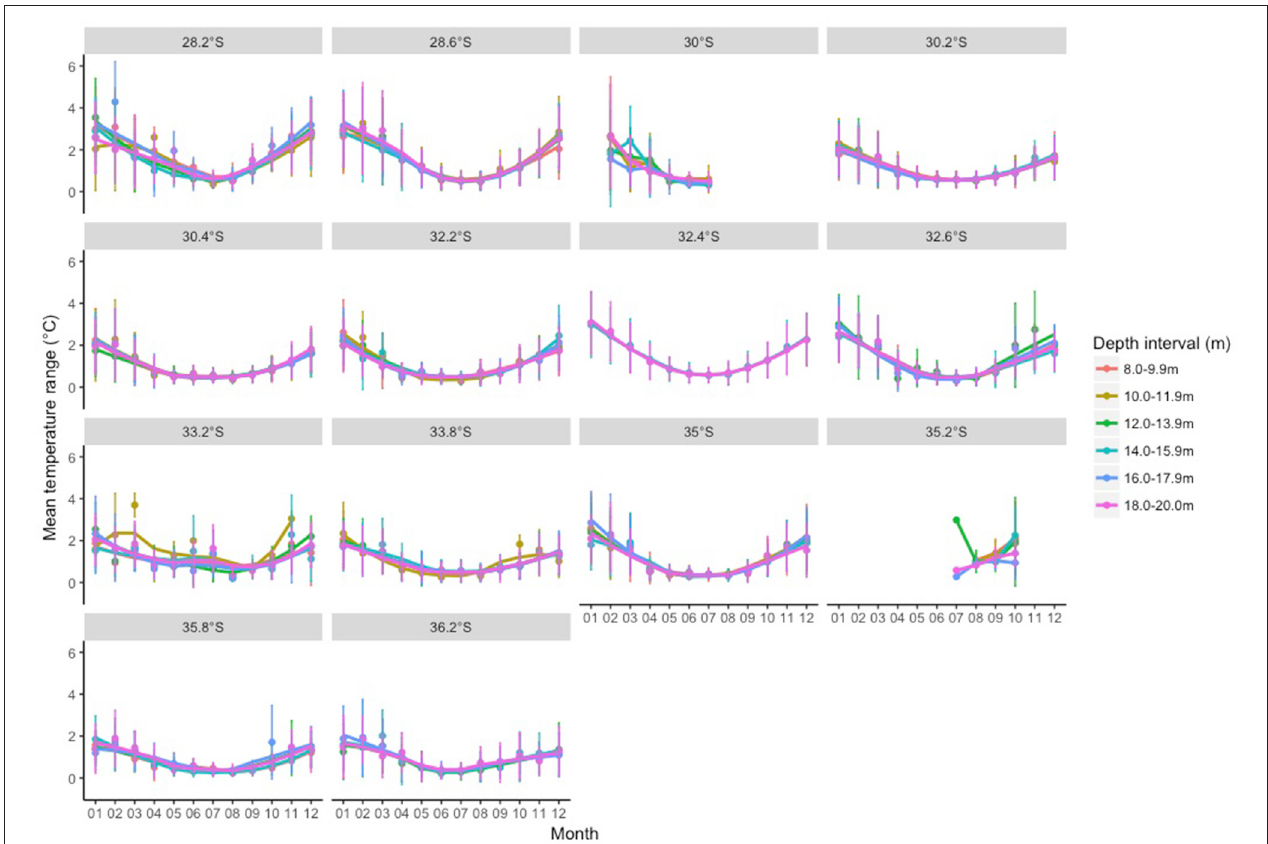
FIGURE 3 | Mean monthly temperature ranges (averaged from daily ranges) for in situ locations across each 0.20 ◦ latitude and 10m depth intervals.